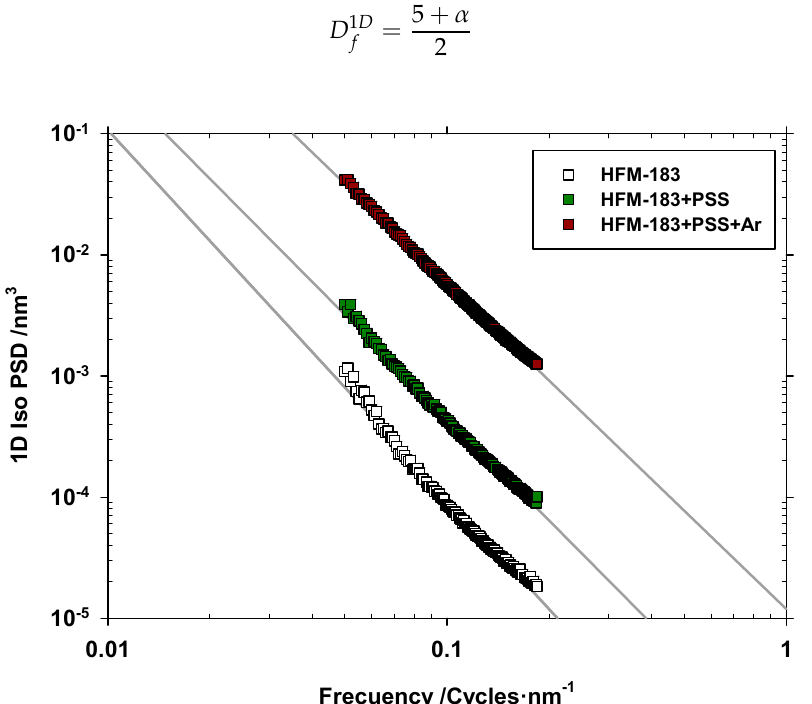
Figure 4. One dimensional PSD versus space frequency.